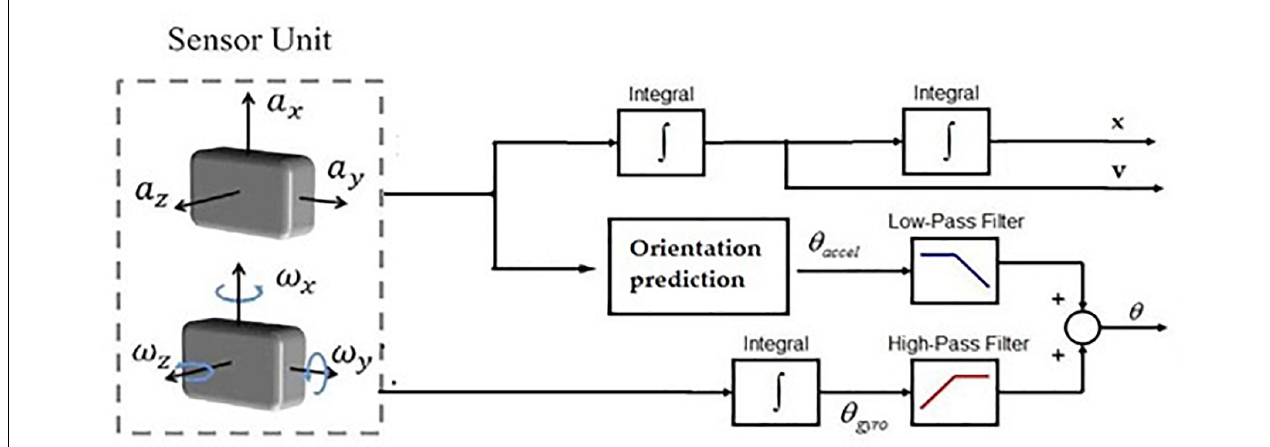
FIGURE 3 | Schematic for IMU-based gait kinematics